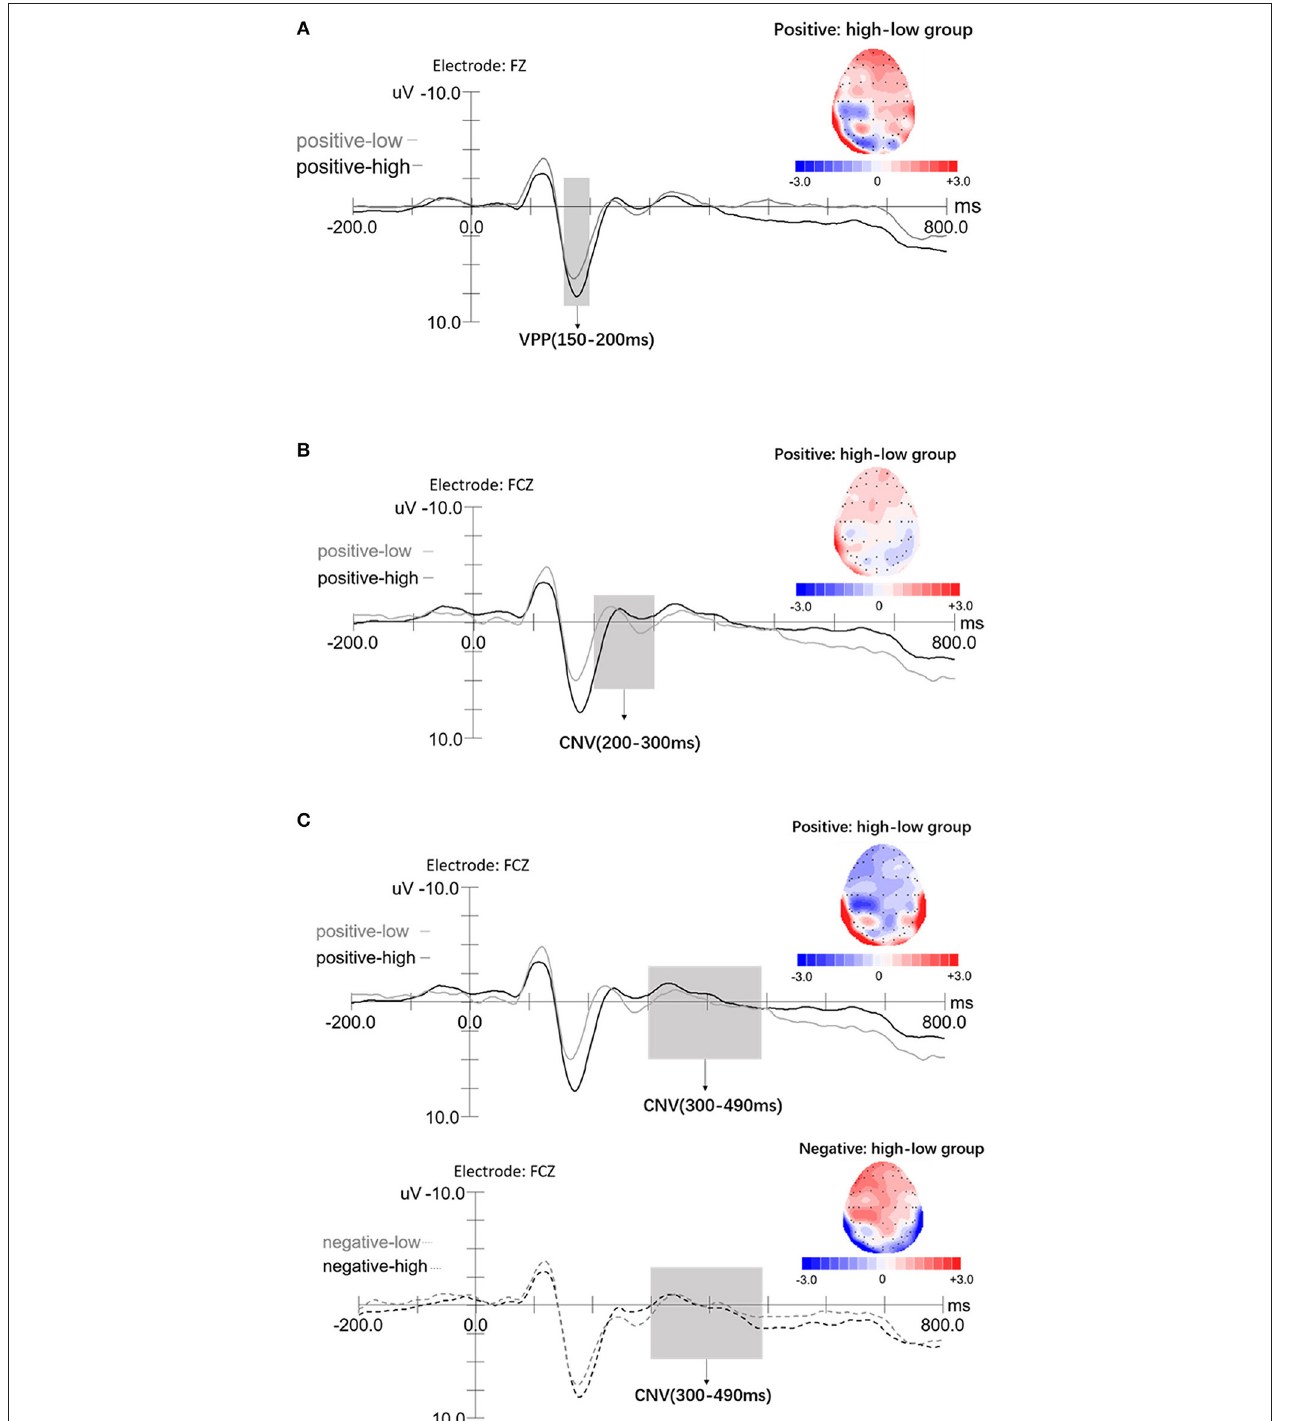
FIGURE 3 | ERPs elicited by the high emotional awareness (black lines) and low awareness (gray lines) displayed for VPP (150–200ms) and CNV (200–300, 300–490ms) components, with − 200 to 800ms time span. The x -axis represents time (ms) and the y -axis represents amplitude ( µ V). (A) Grand-average ERP of the VPP component at the onset of the emotion pictures at Fz for an example diagram; a: topographic maps of difference waves in the positive emotion condition (high awareness group minus low awareness group). (B) Grand-average ERP of CNV (200–300ms) component at the onset of the emotion pictures at frontocentral area (FCz); a: topographic maps of difference waves in the positive emotion condition (high awareness group minus low awareness group). (C) Grand-average ERP of CNV (300–490ms) component at the onset of the emotion pictures at frontocentral area (FCz); a, b: topographic maps of difference waves in the positive emotion and negative emotion (high awareness group minus low awareness group),